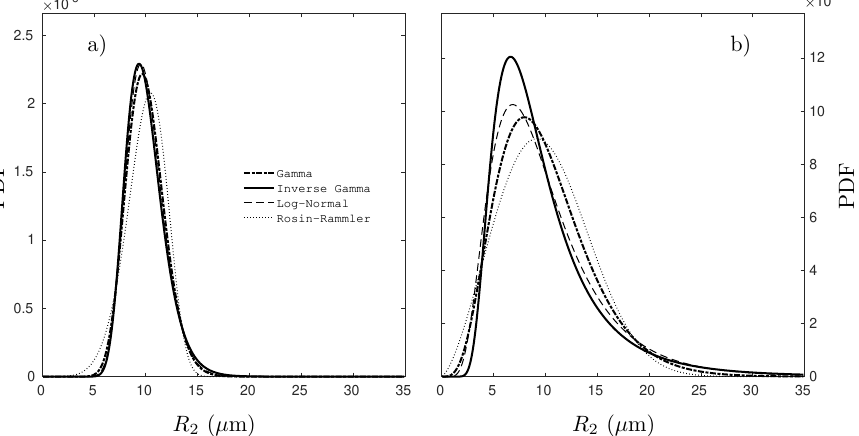
Table A.3: Various parameters of the Gamma, Inverse-Gamma, Log-Normal and Rosin-Rammler PDFs displayed in Fig. A.20.